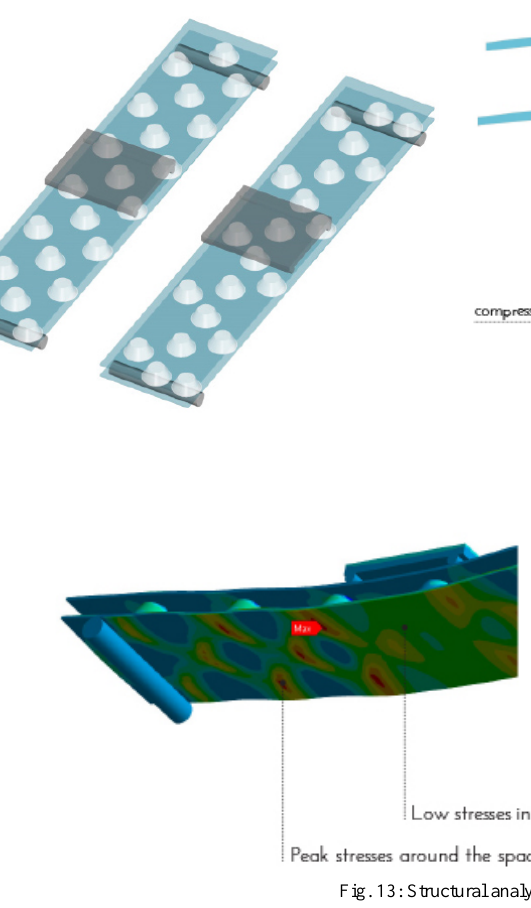
Fig. 13: Structural analysis of the 2